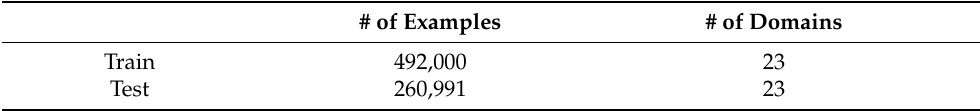
Table 1. Dataset Statistics.